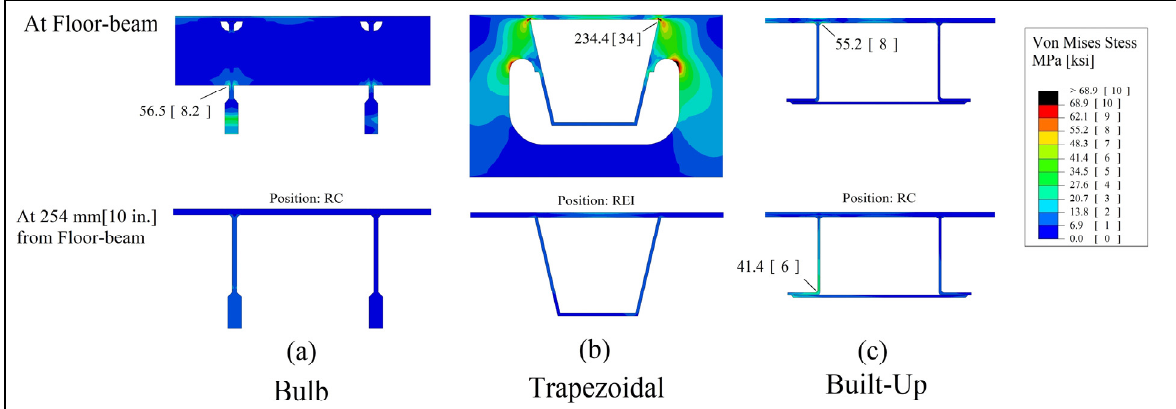
Figure 22. Von Mises stress distribution in continuum case 4.